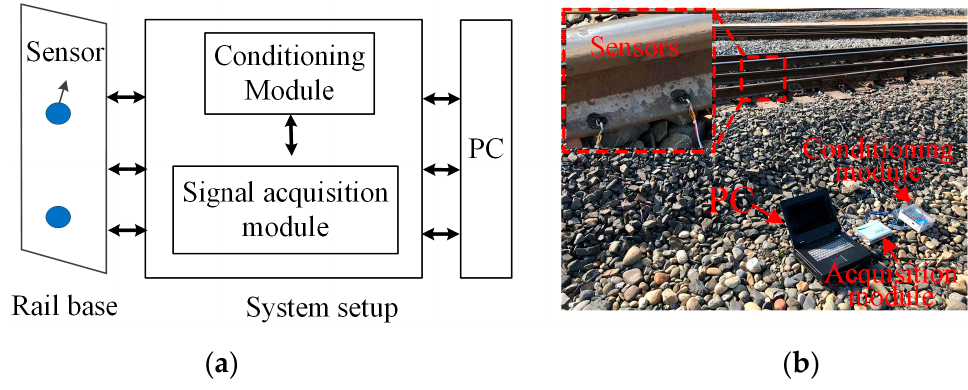
Figure 5. The ( a ) diagram and ( b ) figure of the experimental system.